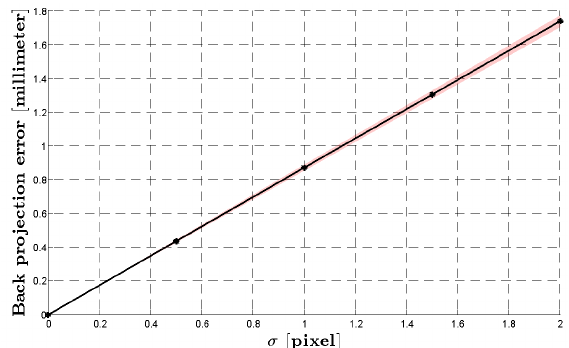
Figure 6: The line-based back-projection error versus the random noised added to the image points. The line-based back-projection error was computed using (16). The shaded area shows the stan- dard deviation of the line-based back-projection error.